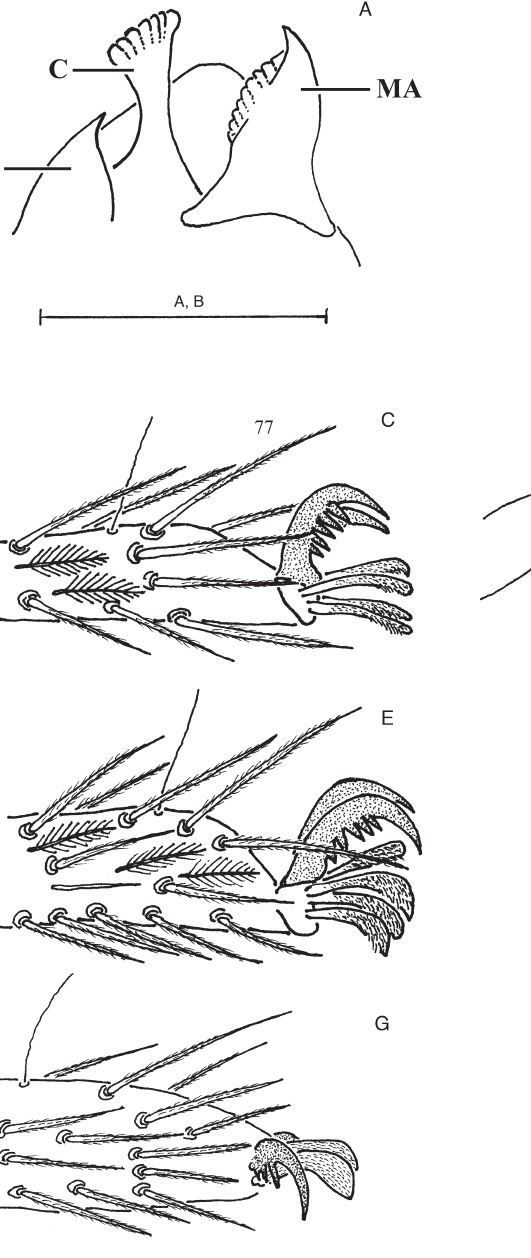
Fig. 11. A. Cteniogaster toxarchus gen. et sp. nov. Tip of male palp, ventral view. B-D. Cteniogaster hexomma sp. nov. B. Tip of male palp, ventral view. C. Tip of male tarsus IV, retrolateral view. D. Bent male tarsus IV. E. Cteniogaster toxarchus gen. et sp. nov., tip of male tarsus IV. F. Apostenus spinimanus (Koch & Berendt, 1854), tip of male tarsus IV. G. Apostenus fuscus Westring, 1851, tip of male tarsus IV. H. Arabelia pheidoleicomes Bosselaers, 2009, tip of female tarsus IV. Scale bars: D = 200 μm; A-C, E-G = 100 μm. Abbreviations: C = conductor; E = embolus; MA = median